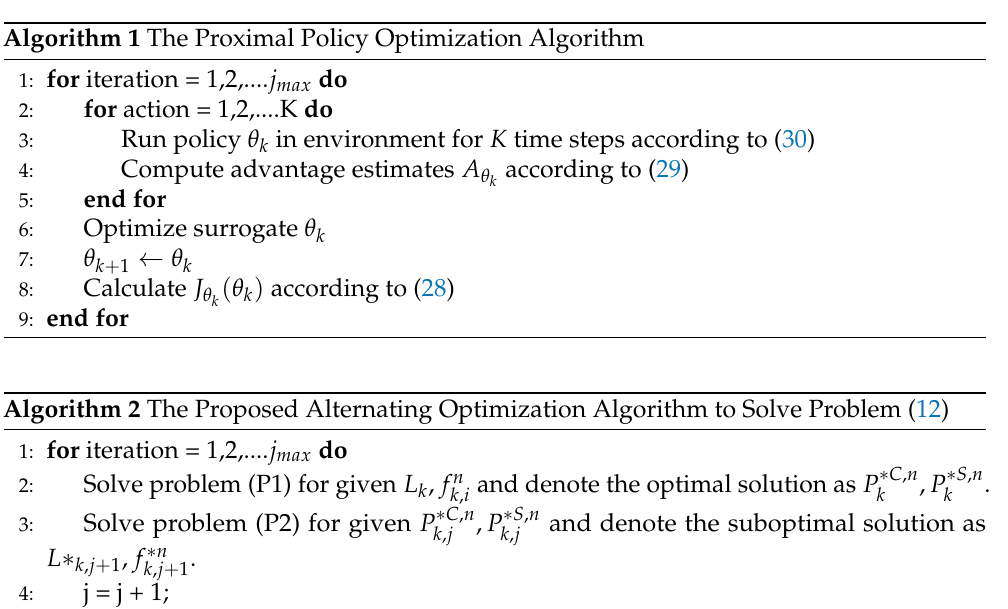
Figure 4. The value of J θ